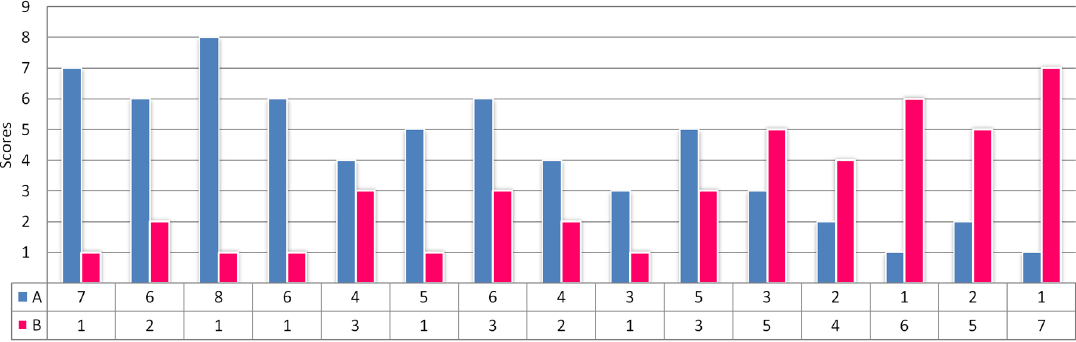
Figure 5. Scores of students A and B along 15 week semester.